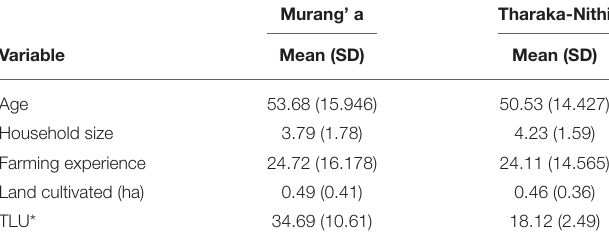
TABLE 3 | Descriptive summary statistics of the sampled smallholder farmers in Murang’ a and Tharaka-Nithi for continuous